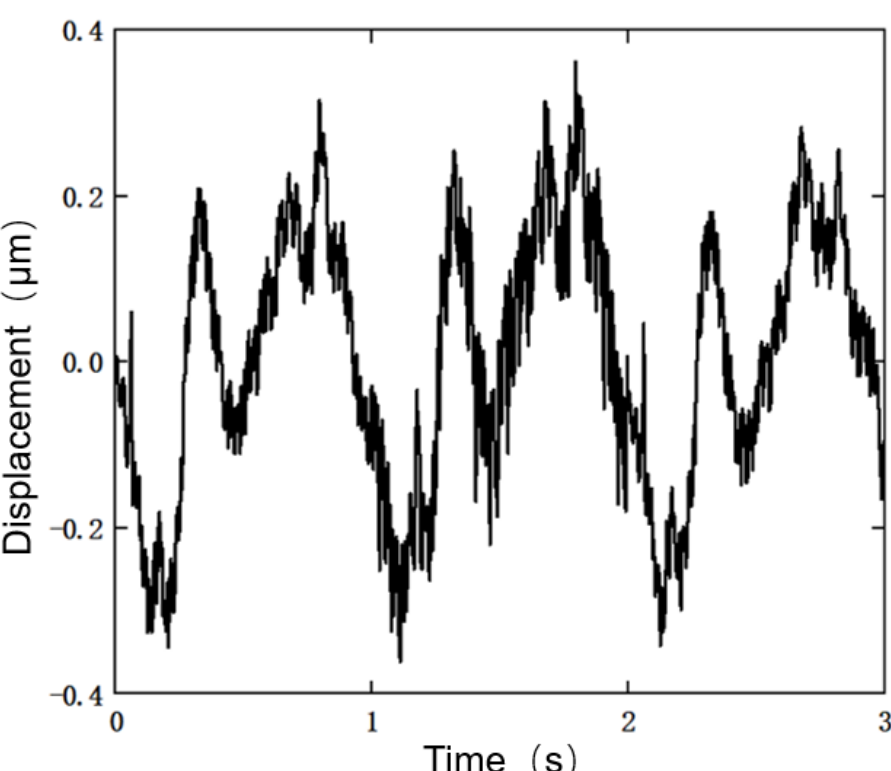
Figure 22. Displacement error diagram of x direction constant-amplitude signal.